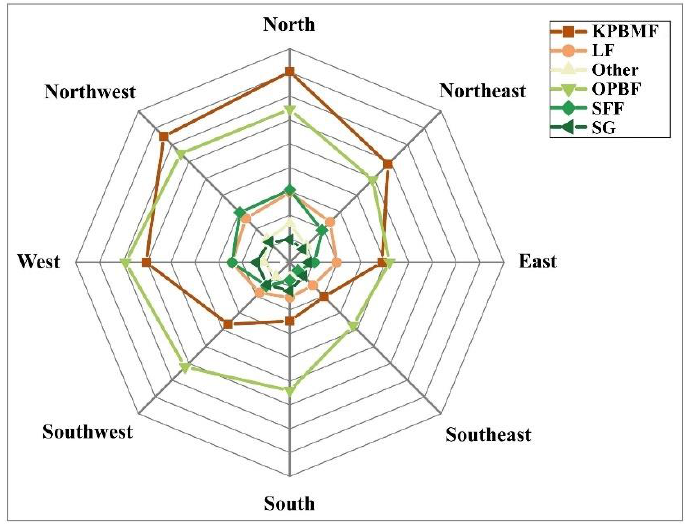
Figure 9. Radar Chart of Tree Species Aspect Distribution.